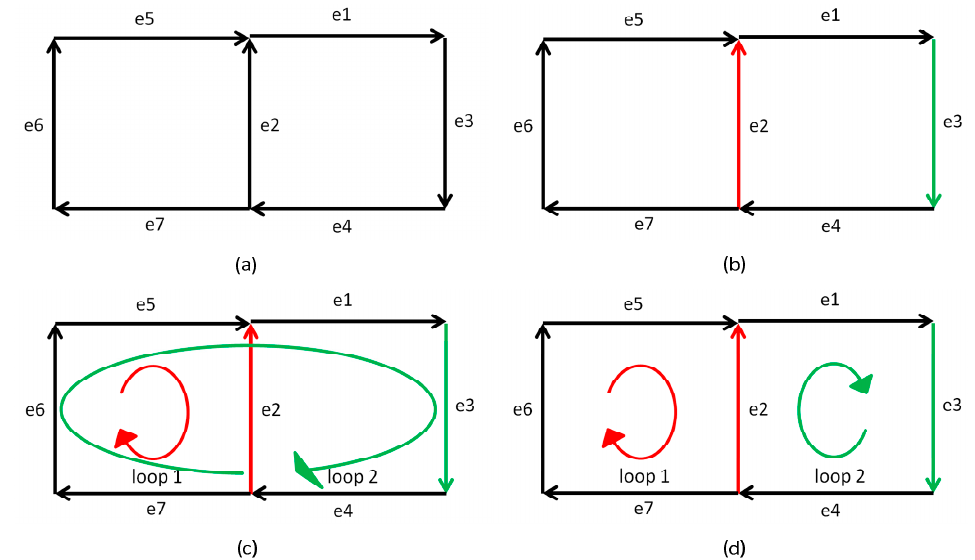
Figure 1. Division of the traditional circuits and the minimum closed loops. ( a ) a simple connected graph; ( b ) a spanning tree; ( c ) the traditional circuits; ( d ) the minimum closed loops.